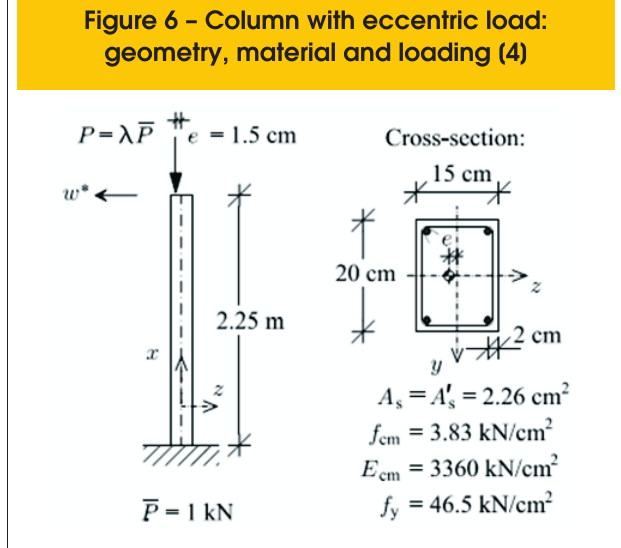
Figure 6 – Column with eccentric load: geometry, material and loading [4]